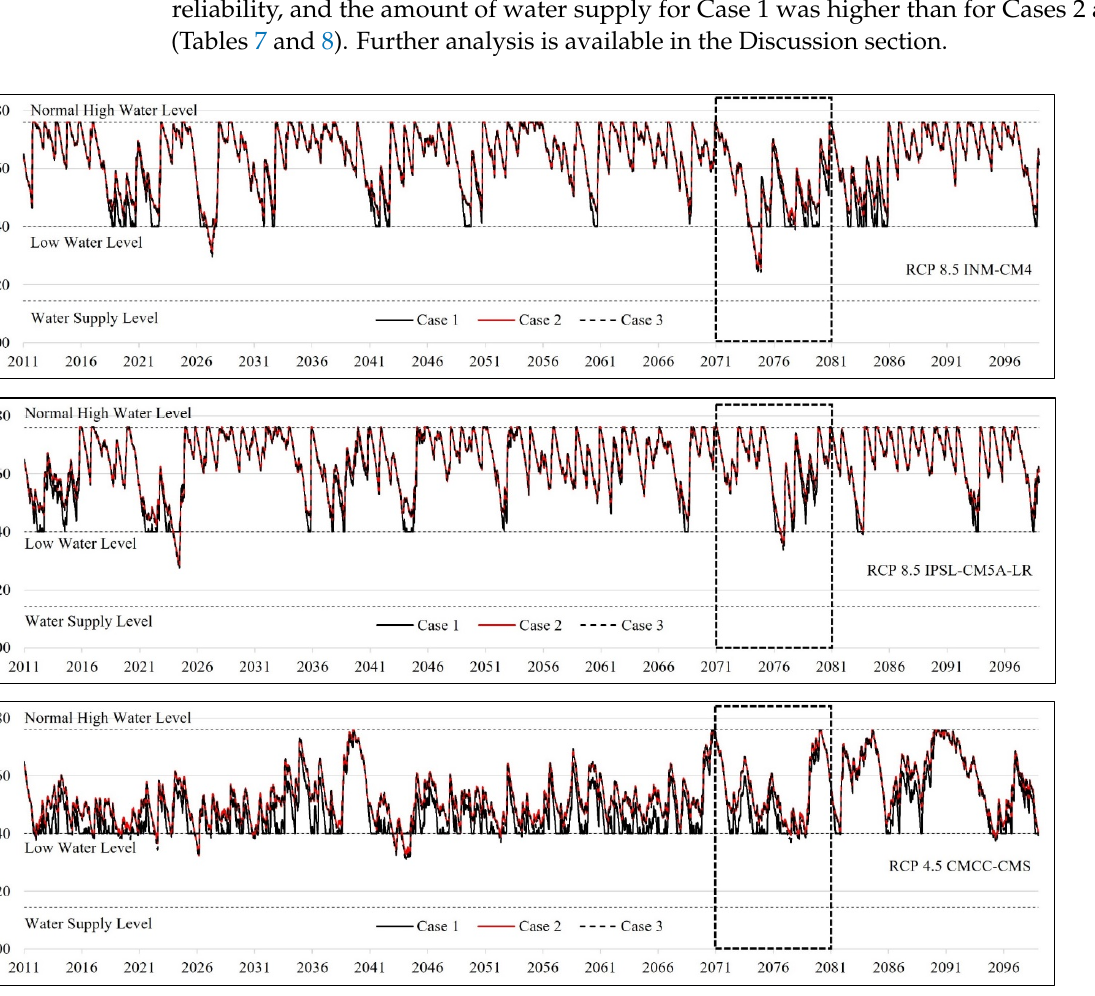
Figure 5. Comparison of the Hapcehon reservoir’s water level for Case 1, 2, and 3 in three climate change scenarios from 2011 to 2100. These three climate change scenarios are RCP 8.5 INM-CM4 ( a ), RCP 8.5 IPSL-CM5A-LR ( b ), and RCP 4.5 CMCC-CMS ( c ). The dotted black box highlights the extreme drought period (from 2070 to